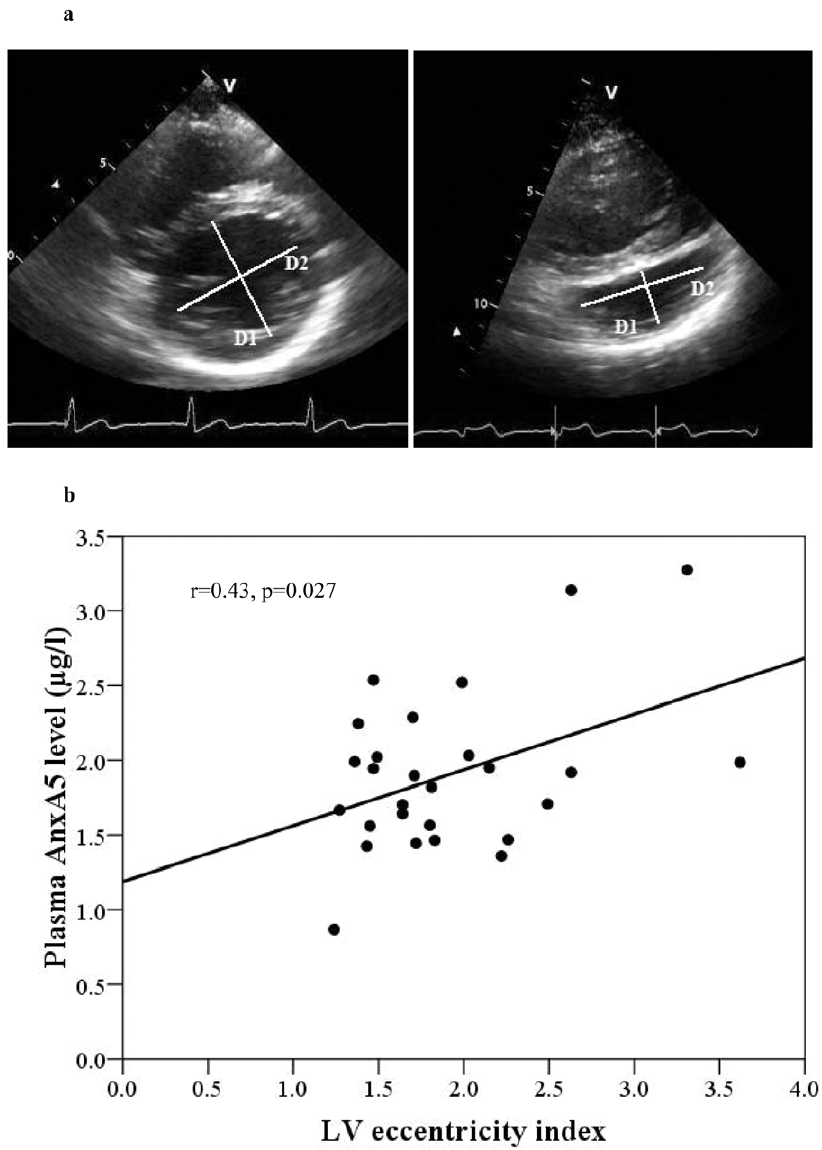
Figure 2. (a) Derivation of eccentricity index from a patient (right) and a control subject (left). D1 is the maximum distance from the surface of the mid-ventricular septum to that of the LV free wall and D2 is the antero-posterior distance measured perpendicular to D1. (b) Scatter plot showing significant correlation between subpulmonary left ventricular (LV) eccentricity index and plasma annexin A5 (AnxA5) level.